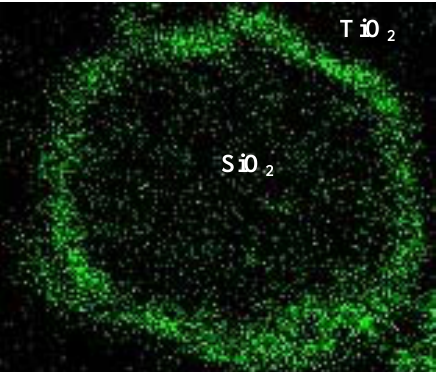
Figure 1. A typical EDX mapping of titania/silica mixed oxide support at low concentrations of